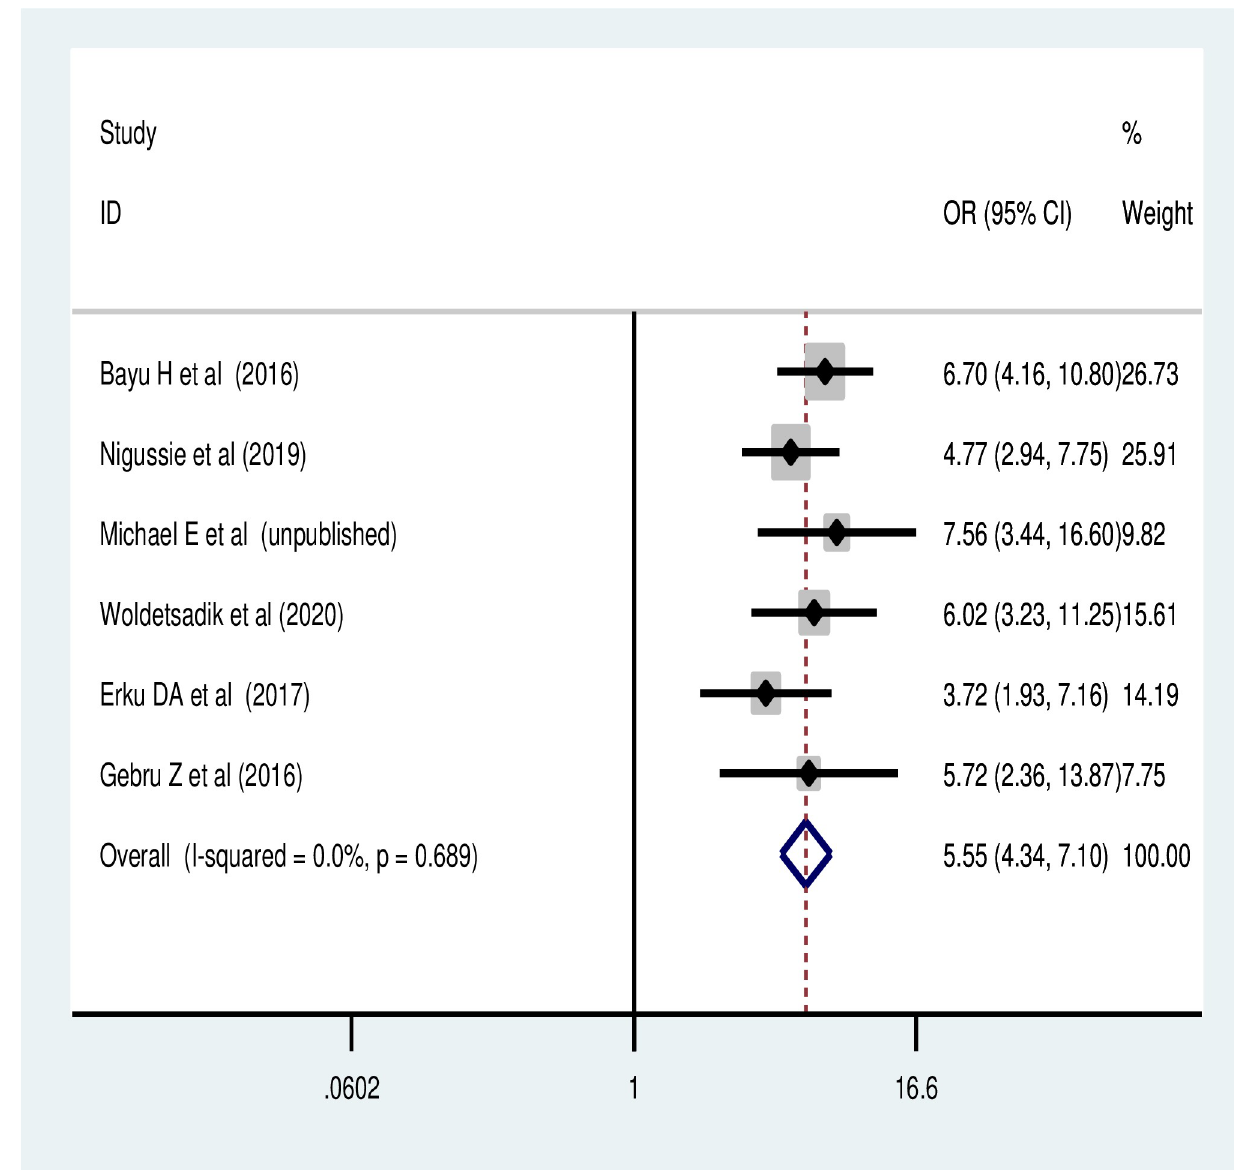
Fig 6. Association of perceived susceptibility to cervical cancer with cervical cancer screening.